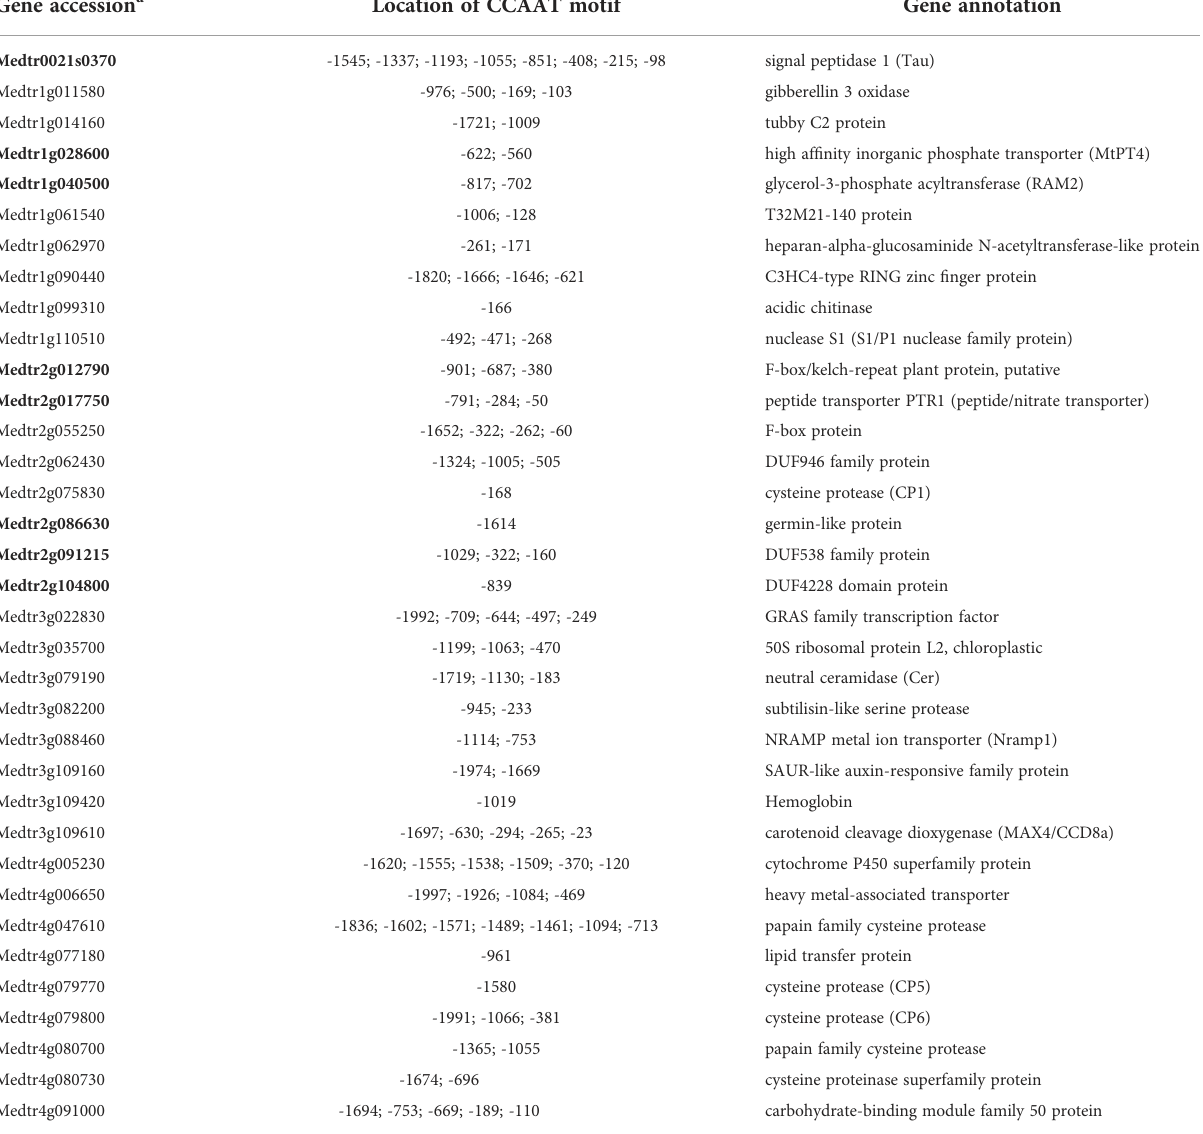
TABLE 1 The location of CCAAT motifs were extracted from the 2 kbp upstream region of differentially expressed genes in mtpt4 mutants.